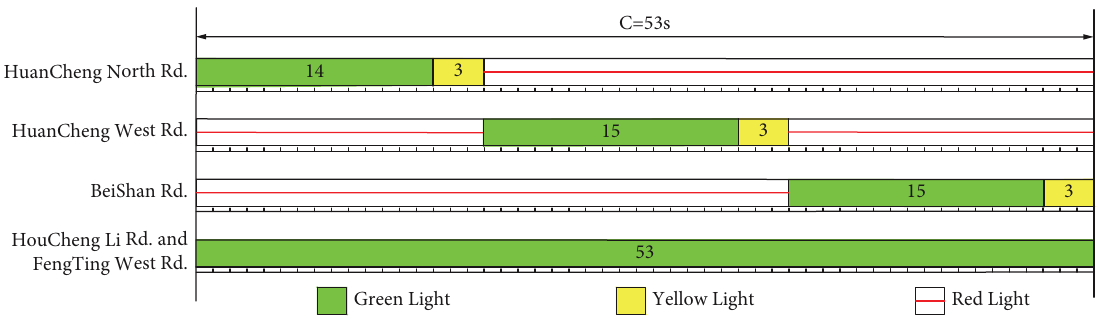
Figure 5: Optimized signal timing in cycle 1 for the model output scheme.